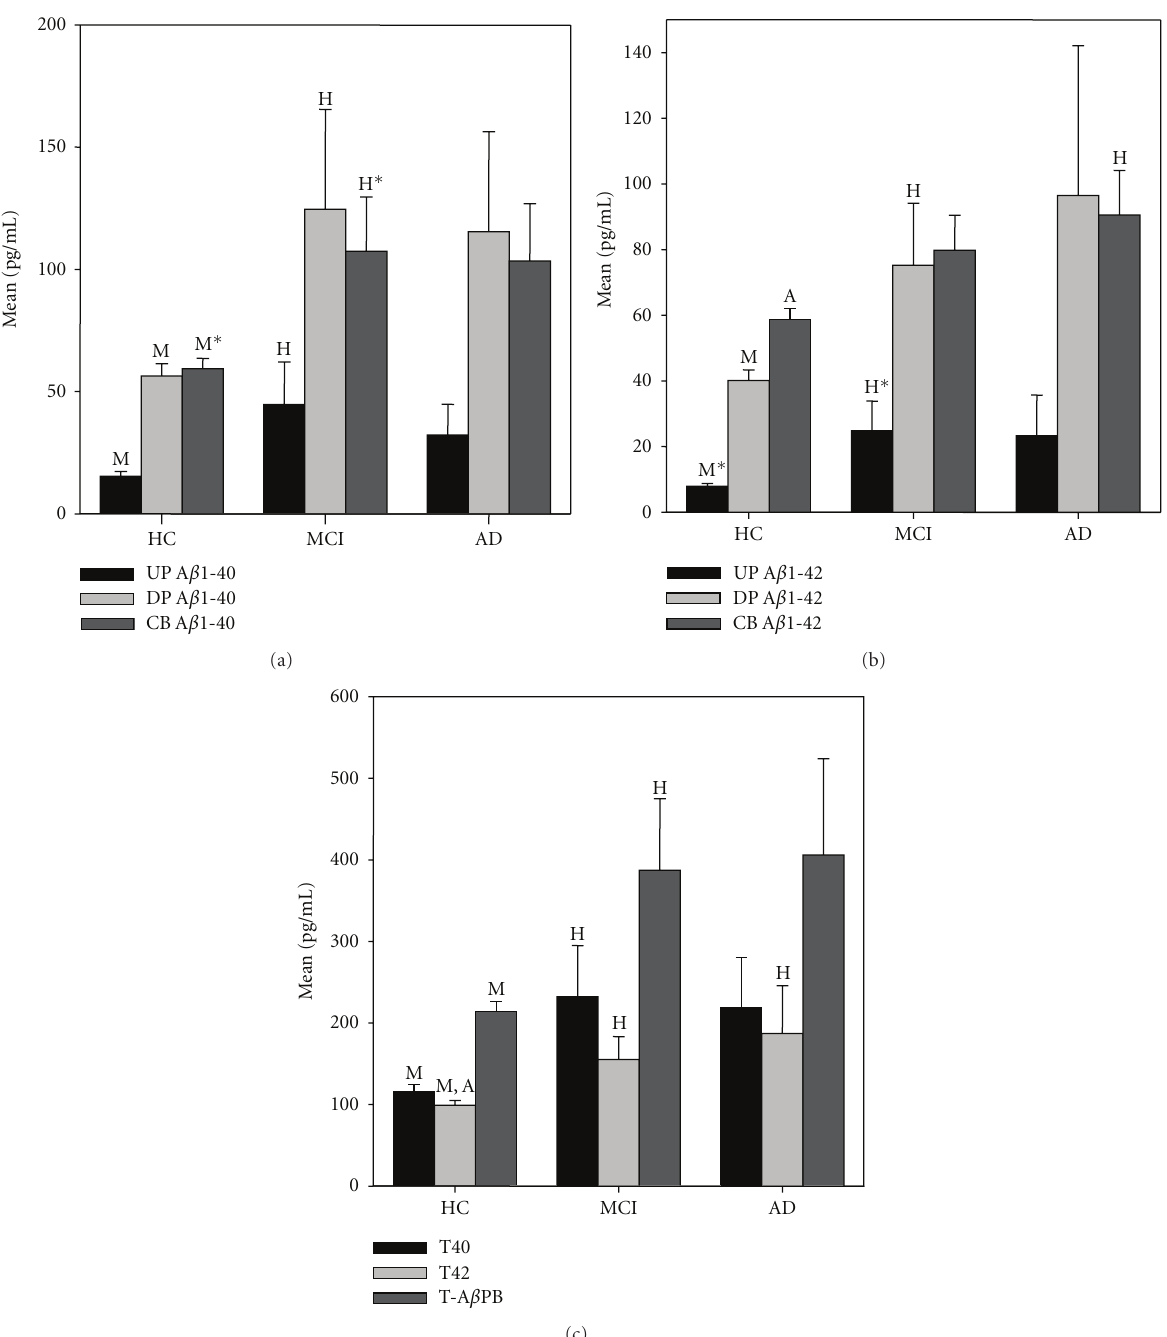
Figure 1: ((a)–(c)). Bar graphs of (a) A β 1–40, (b) A β 1-42 direct markers and (c) T40, T42, and total β APB (T-A β PB) calculated markers. H, M, and A represent significance ( P < 0 . 05) with regard to HC, MCI, and AD, respectively. ∗ means P < 0 .